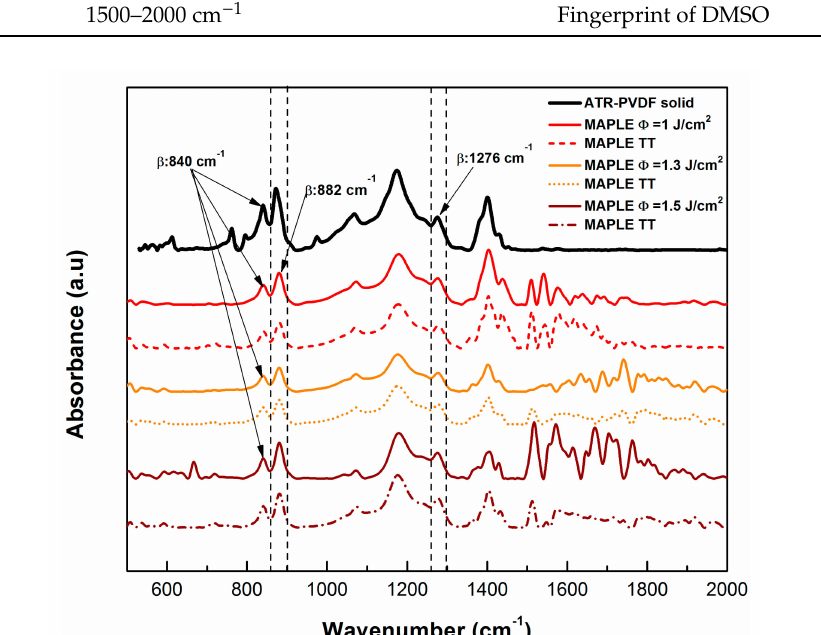
Figure 1. FTIR attenuated total reflectance (ATR) and FTIR spectra of PVDF coatings deposited by matrix-assisted pulsed evaporation (MAPLE) and of the coatings subjected to the thermal treatment (MAPLE TT). The spectrum of the PVDF initial material are marked as a continuous black line, while the other continuous lines stand for the PVDF coatings transferred by MAPLE and the dotted lines stand for the PVDF coatings transferred by MAPLE and those that were thermally-treated (MAPLE